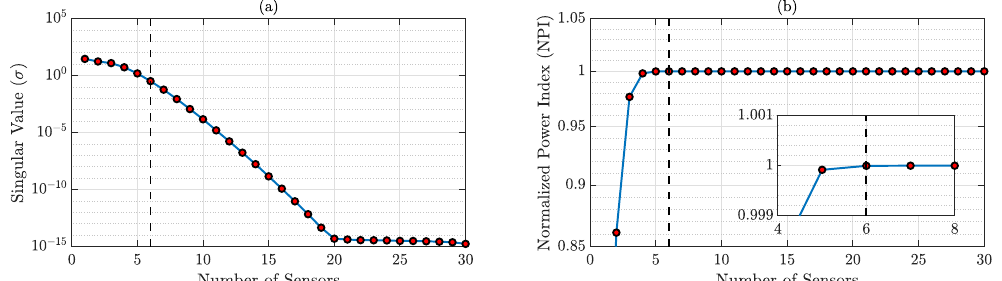
Figure 14. ( a ) SVs of physics-guided basis matrix, ( b ) NPIs for different sensor numbers. NPI → 1 when there are 6 sensors (shown in the zoomed-in